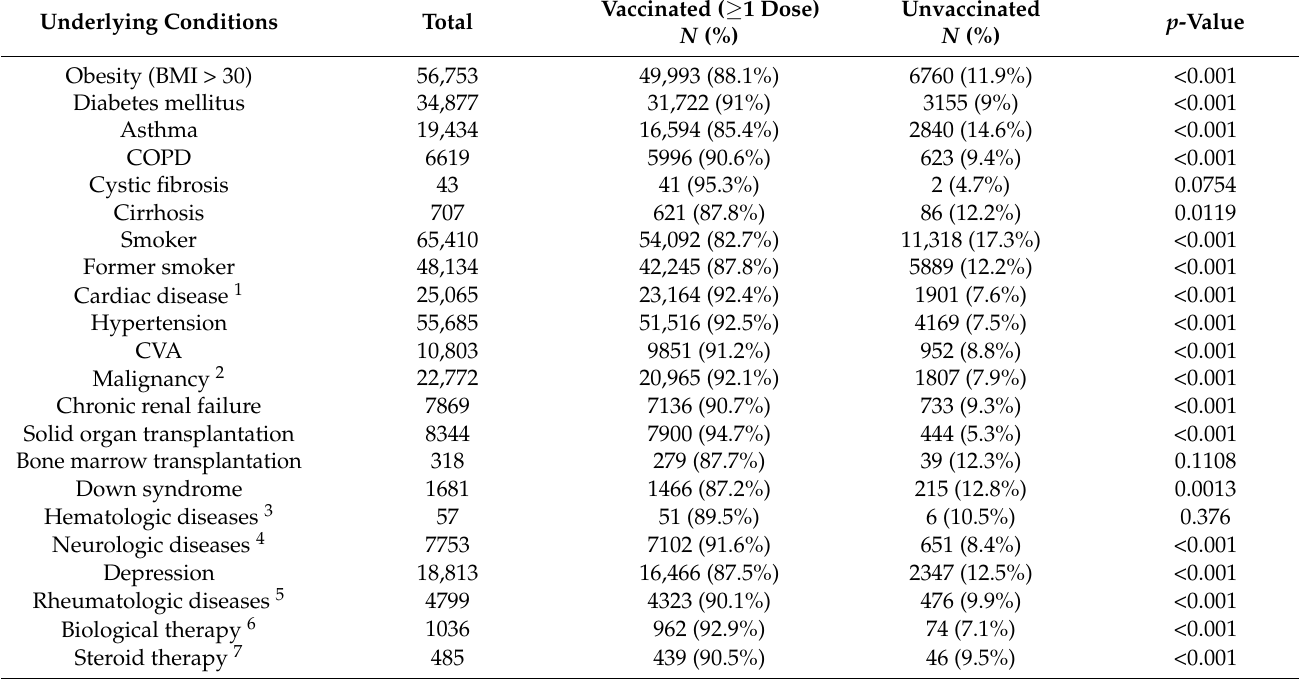
Table 2. Vaccination against COVID-19 by underlying medical